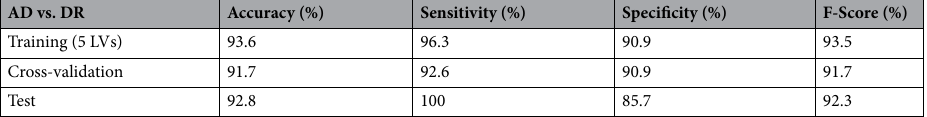
Table 2. Classification parameters for plasma samples in active disease (AD) vs. disease remission (DR).